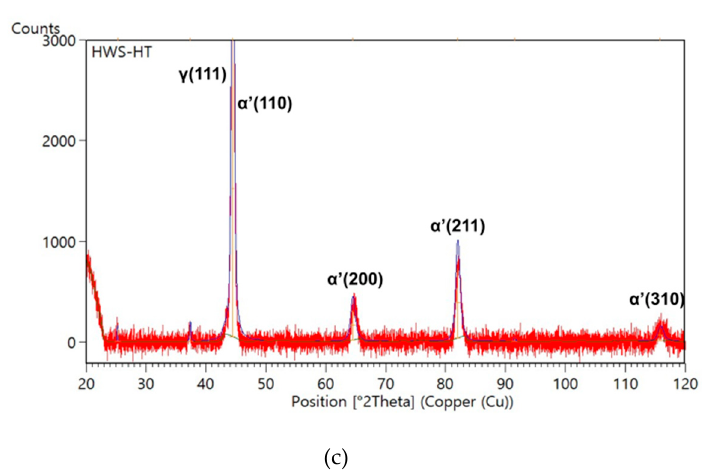
Figure 5. X-ray diffraction patterns of the ( a ) deposited M4 layer, ( b ) deposited HWS, and ( c ) HT-HWS.